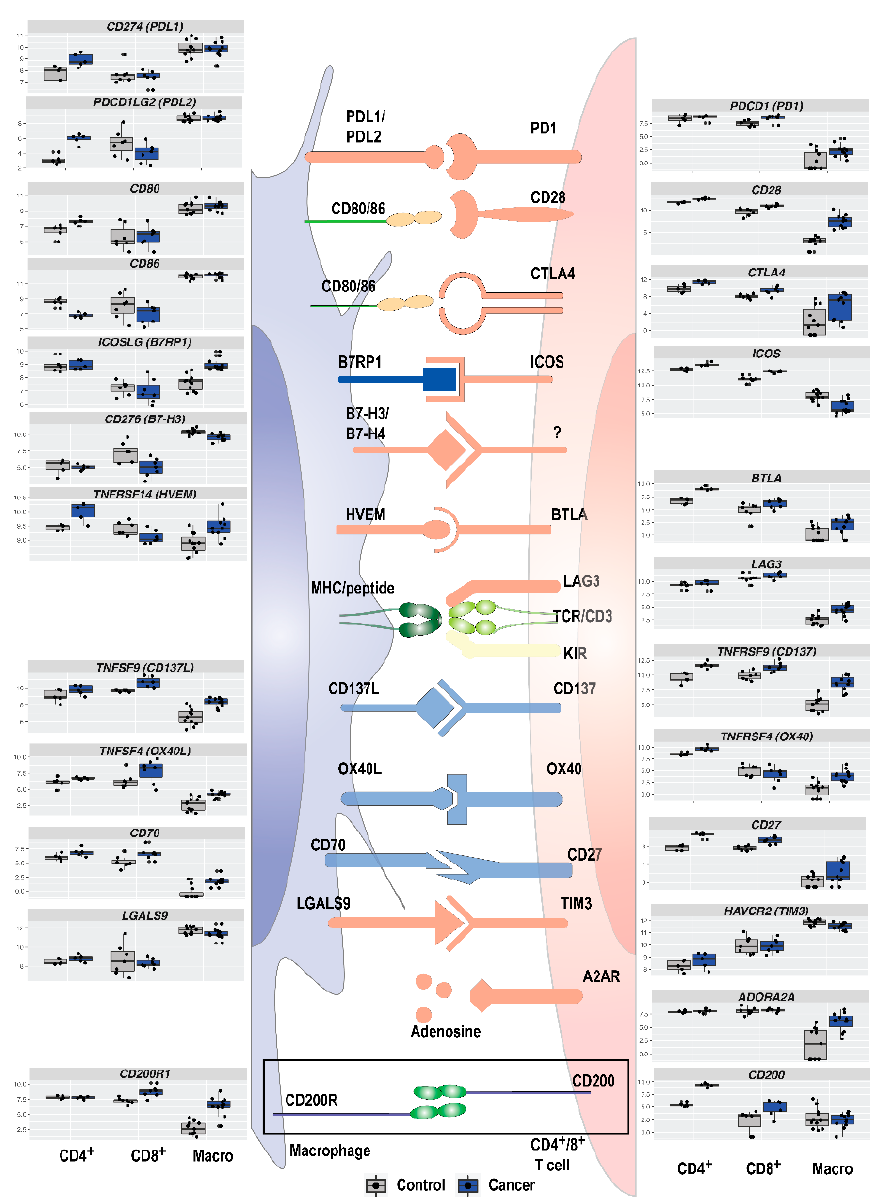
Figure 5. In addition to well-known immune checkpoints PD-1/PD-L1 and CTLA-4, a multitude of immune checkpoints and immunosuppressive pathways regulate the adaptive immune response in NSCLC. Legend: In the immune synapse between intra-tumoral antigen-presenting cells and effector cells, an increasing number of known or putative immune checkpoints regulate the immune response. Boxplots on the sides show expression profiles for individual immune checkpoint genes in macrophages, CD4 + and CD8 + T cells isolated from healthy tissue (grey) and lung cancer (blue).